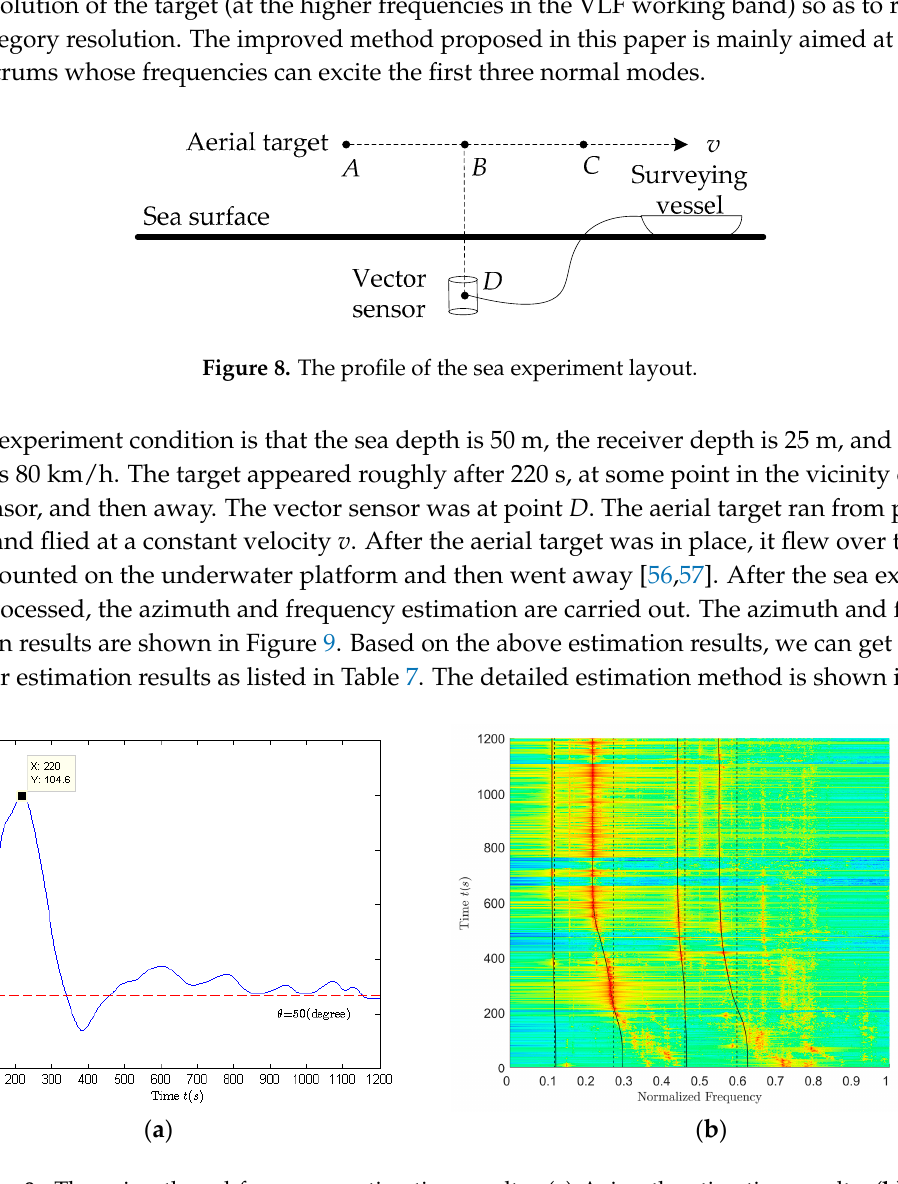
Figure 9. The azimuth and frequency estimation results. ( a ) Azimuth estimation results; ( b ) The normalized spectrum of v z signal and its frequency sequence extraction results.